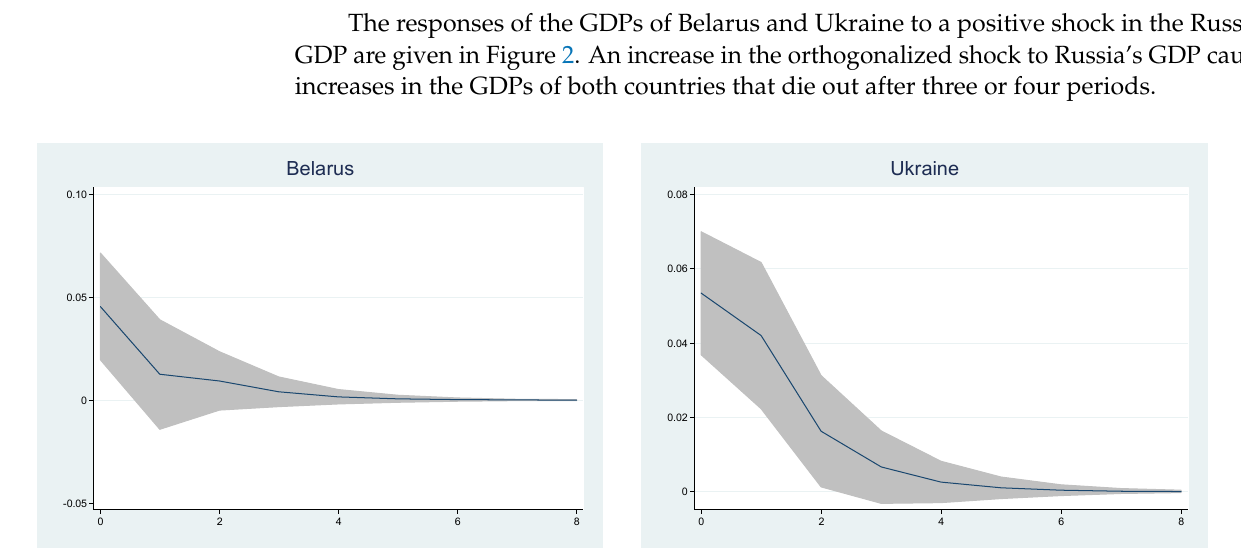
Figure 2. Impulse Response Functions (IRFs) of the VAR Model, Large Economies. Note: Responses of the GDPs of CIS countries to Russia’s GDP.